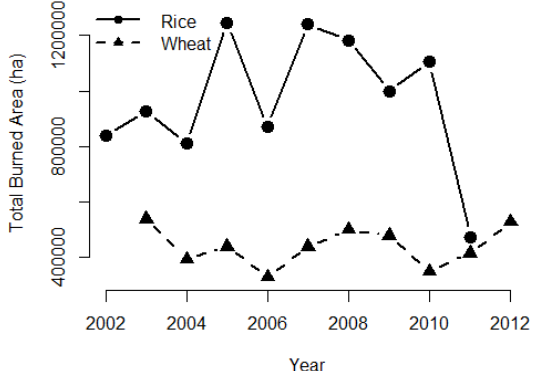
Figure 5. Total areas under fire during rice and wheat harvesting seasons in Punjab.